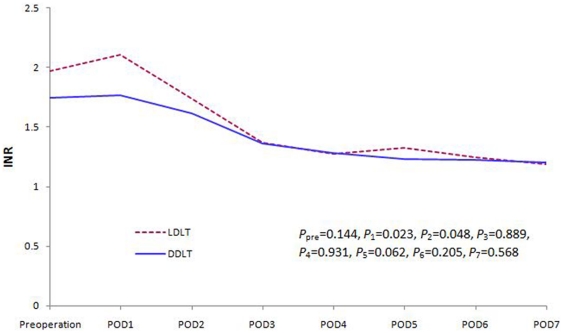
INR level changes during the first postoperative week (P
pre
 = 0.144, P
1 = 0.023, P
2 = 0.048, P
3 = 0.889, P
4 = 0.931, P
5 = 0.062, P
6 = 0.205, P
7 = 0.568).